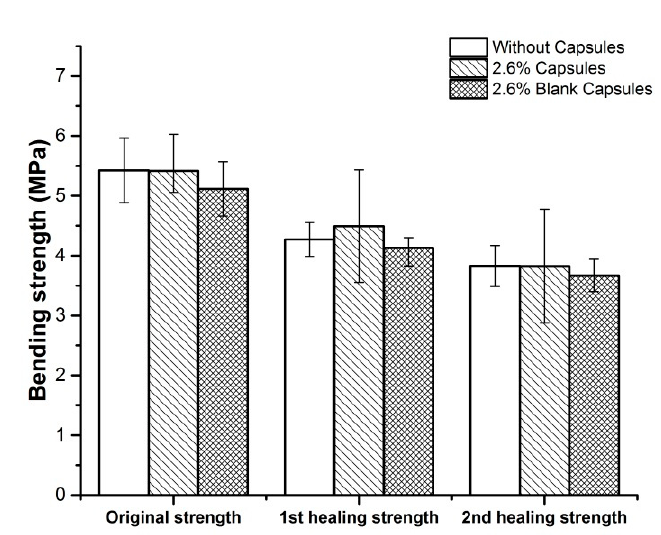
Figure 8. Bending strength of asphalt mortar beams.